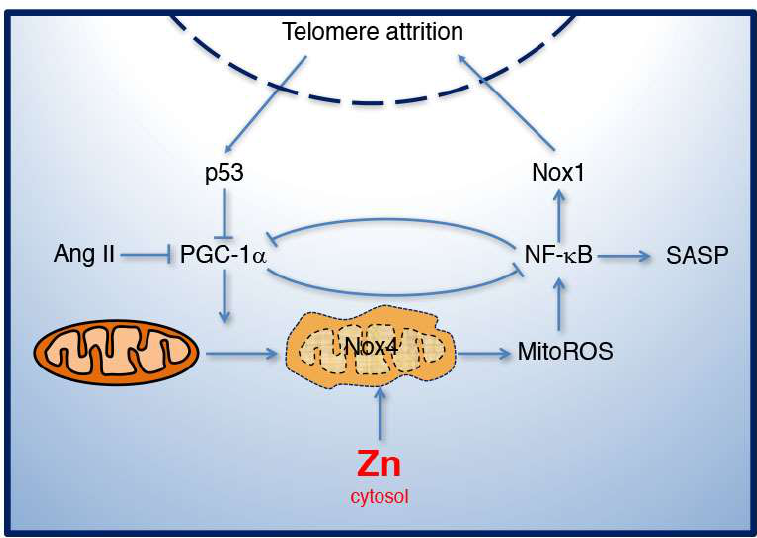
Figure 3. PGC-1 α and Nox1 in telomere and mitochondrial dysfunction during aging. Telomere dysfunction induces mitochondrial dysfunction through the p53-dependent downregulation of PGC-1 α . Dysfunctional mitochondria produce mitochondrial ROS (MitoROS) that activates NF- κ B-dependent upregulation of Nox1, causing telomere attrition and replicative senescence. Ang II induces senescence by inhibiting PGC-1 α function, while zinc overload causes senescence by increasing MitoROS and Nox1 expression. In conditions of stress, Nox4 localizes in the mitochondria, also contributing to MitoROS